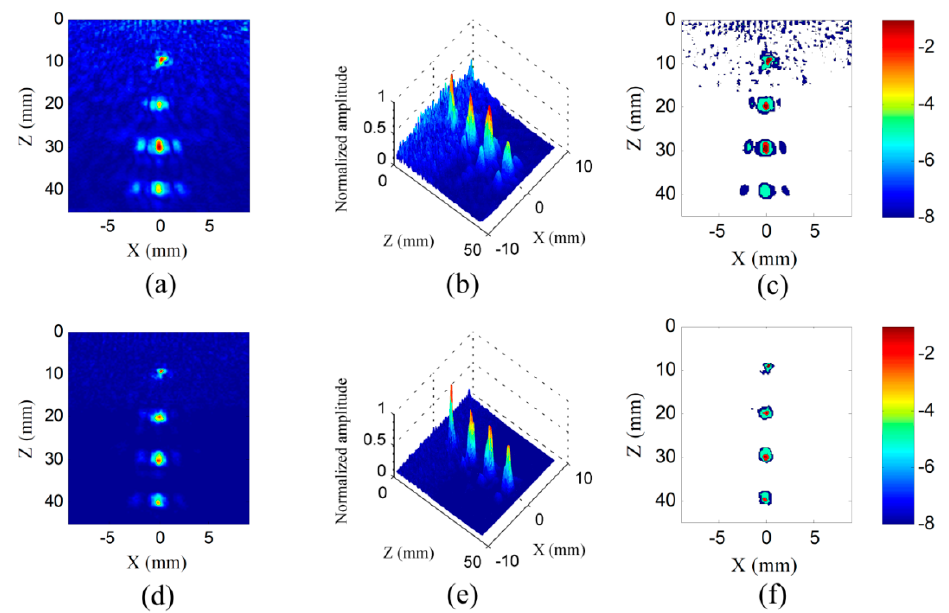
Figure 11. The hybrid full matrix of specimen 2 processed by ( a , b ) TFM and ( d , e ) SCF. Corresponding point-spread functions: ( c ) TFM and ( f ) SCF.